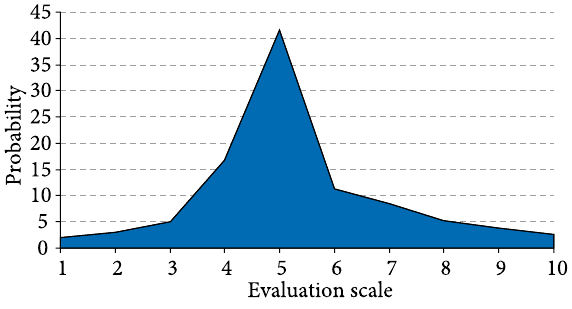
Fig. 2 . Example of evaluation (P82)